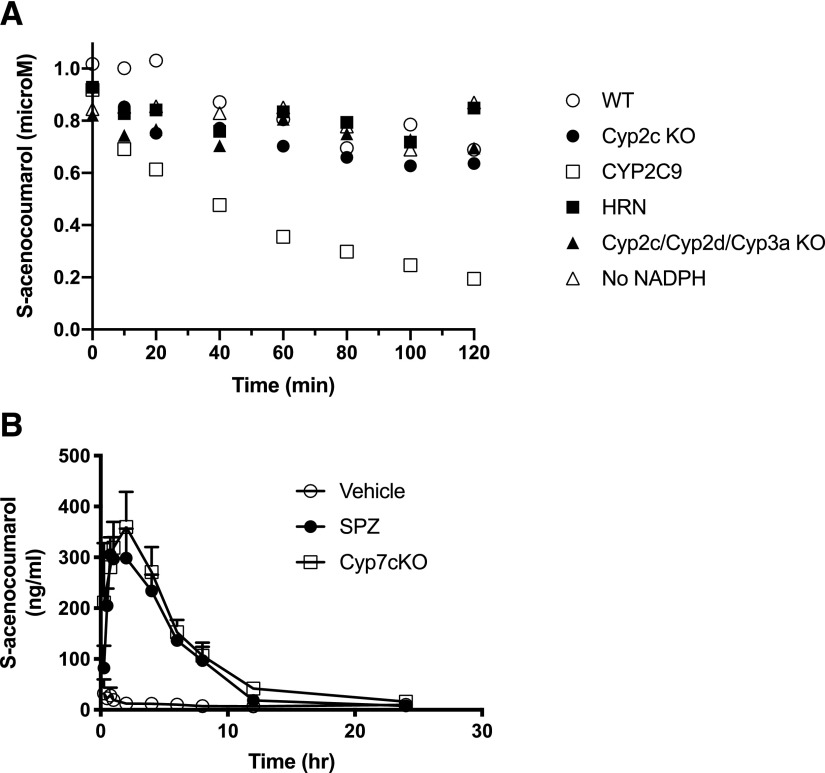
S-Acenocoumarol is a specific CYP2C9 probe drug in humanized mice. (A) In vitro microsomal stability assay. Liver microsomes from wild-type (open circles), CYP2C9 (open squares), Cyp2cKO (closed circles), Cyp2c/Cyp2d/Cyp3aKO (closed triangles), and hepatic P450 reductase null (HRN) (closed squares) mice were incubated with S-acenocoumarol and disappearance of drug monitored over time as described in Materials and Methods. Wild-type liver microsomes without NADPH (open triangles) were included as a control group. (B) Pharmacokinetics of S-acenocoumarol in 8HUM and CypC4KO mice. Female 8HUM and CypC4KO mice (n = 3) were treated with SJW and then administered S-acenocoumarol individually (open circles) or in combination with sulfaphenazole (closed circles) before PK profiling for S-acenocoumarol as described in Materials and Methods. 8HUM mice treated with SJW alone (open circles), 8HUM mice treated with SJW and sulfaphenazole (SPZ; closed circles), and CypC4KO mice were treated with SJW followed by S-acenocoumarol alone (open squares). Values show are mean ± S.D.